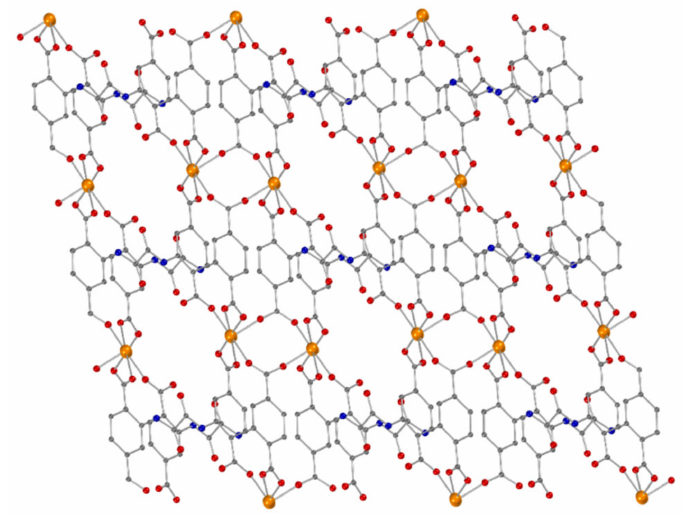
Figure 1. The 3D framework of the 3D-Fe-MOF down to the a axis. Color code: Fe orange, C, grey, H cyan, O red, N blue.